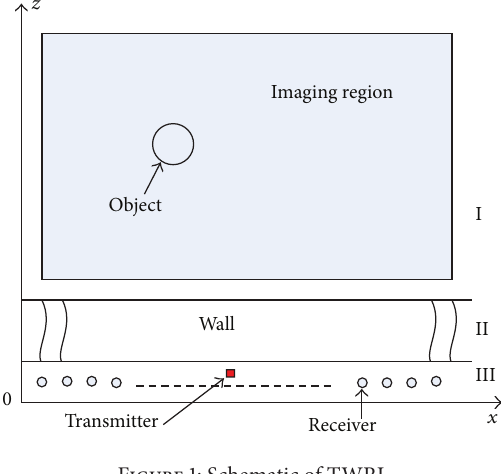
Figure 1: Schematic of